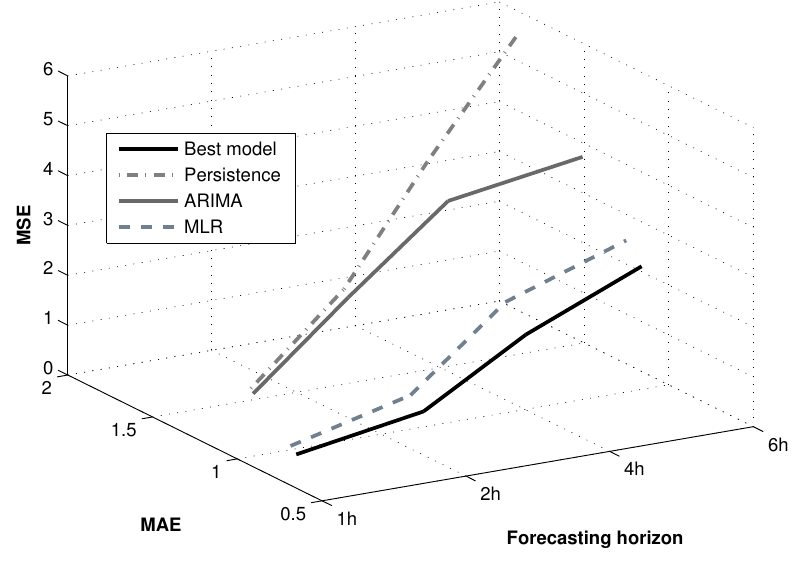
Figure 14. Evolutions of the MAE and MSE errors obtained by the best model in the function of the forecasting